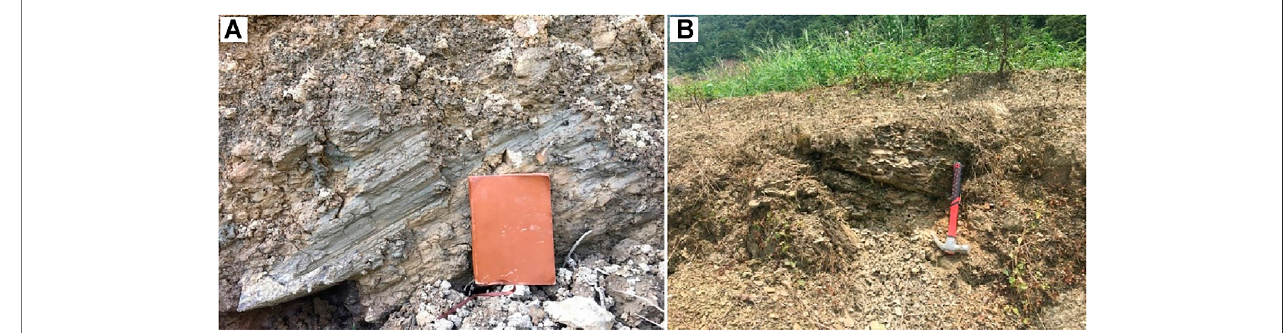
FIGURE 7 | (A) Scratch and (B) broken rock. See Figure 3 for the locations of pictures.